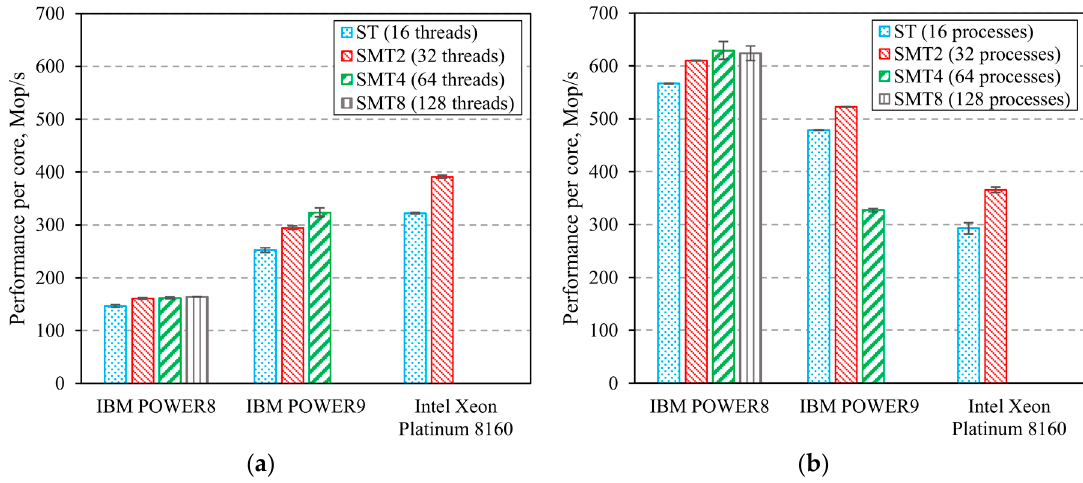
Figure 7. CG Class D benchmark results: OpenMP version ( a ) and MPI version ( b ).